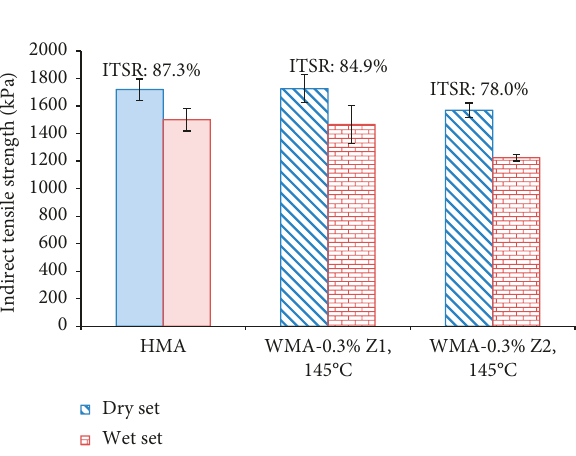
Figure 6: Results of the water sensitivity test for HMA and WMA with subproduct zeolite.